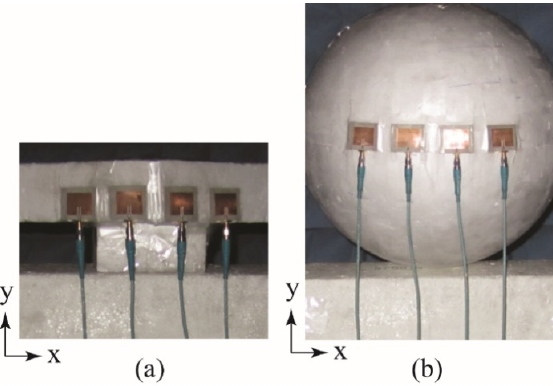
Figure 5. ( a ) Photograph of the four-element beamforming array being measured on the singly curved non-conducting wedge surface with θ b = 30 ◦ and ( b ) photograph of the four-element beamforming array being measured on the cylindrical-shaped surface with r = 10 cm.